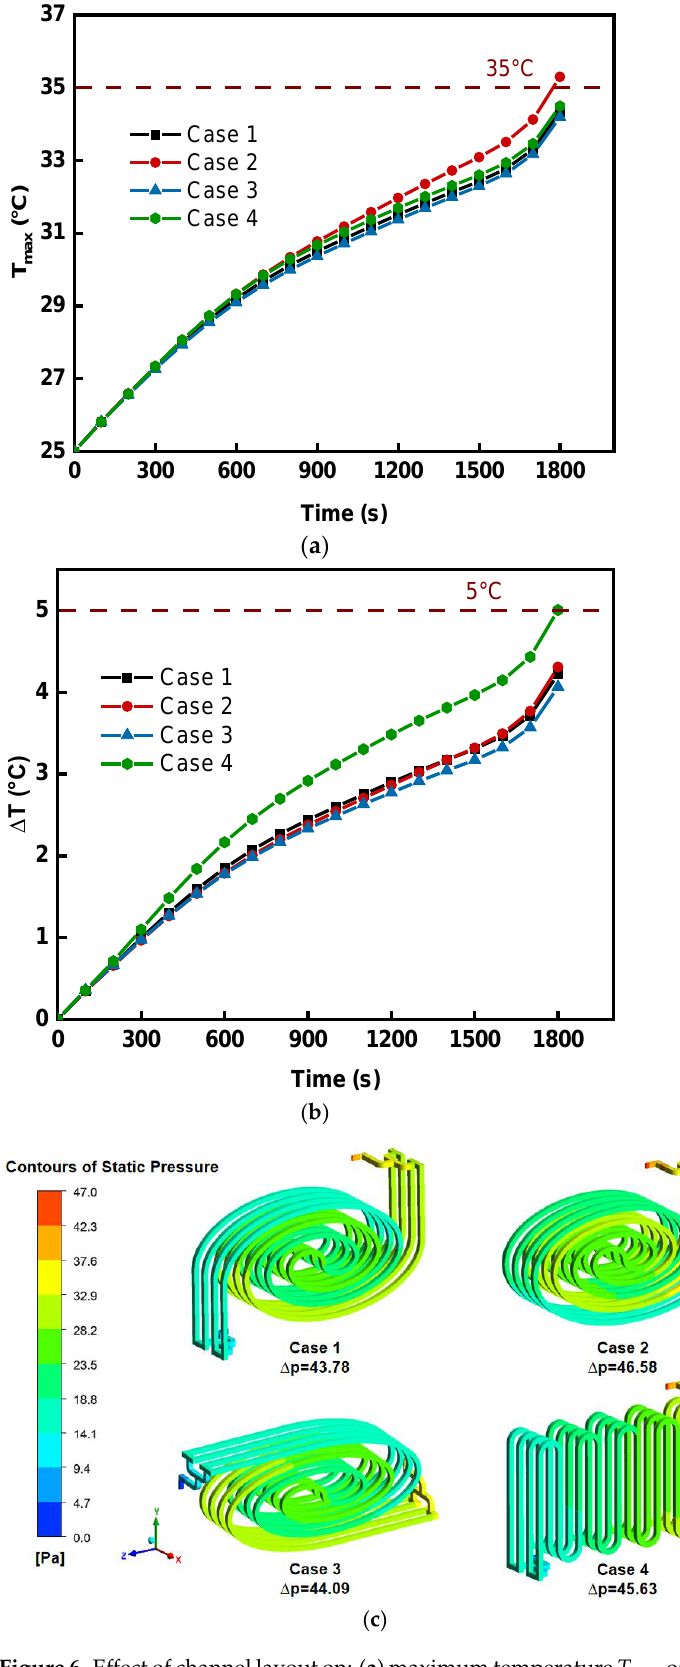
Figure 6. Effect of channel layout on: ( a ) maximum temperature T max of battery module; ( b ) maximum temperature difference ∆ T of battery module; ( c ) channel pressure drop ∆ p .